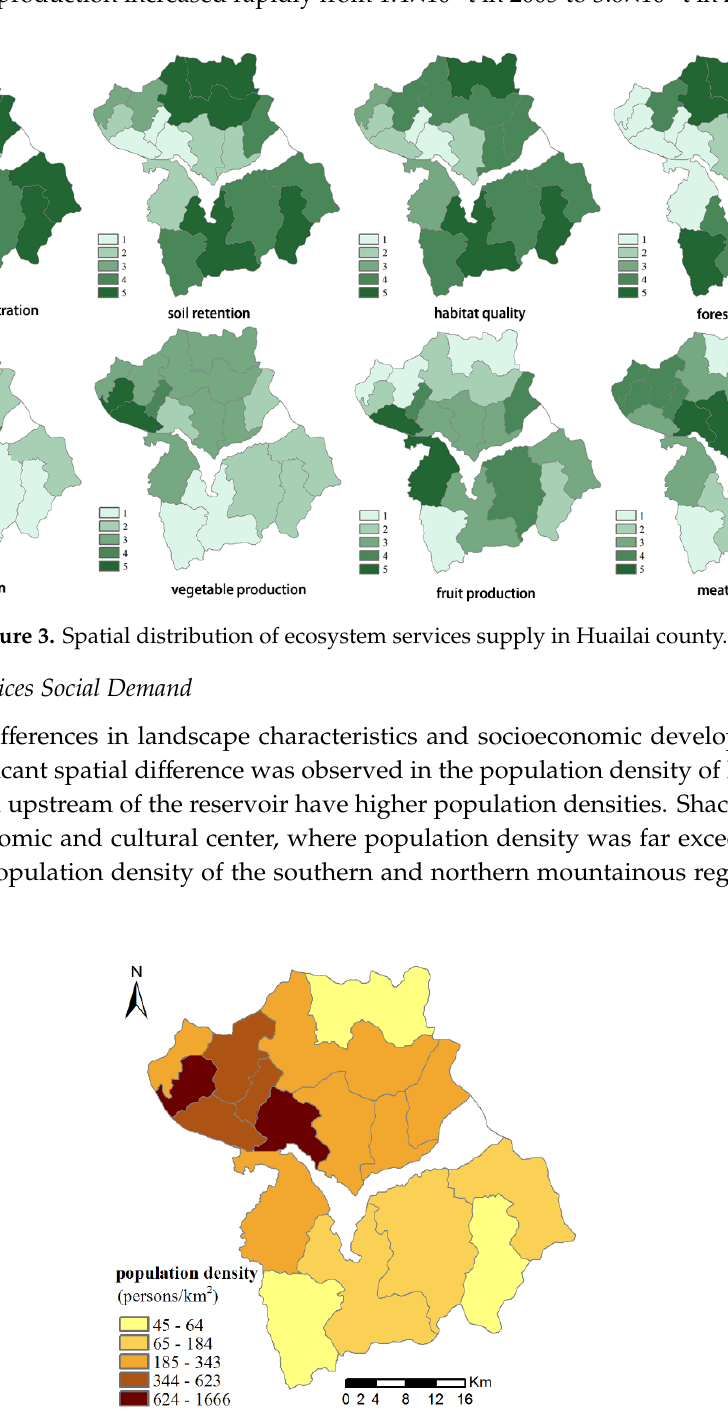
Figure 2. Huailai County stakeholders’ perception of changes in ecosystem services (ES) over the